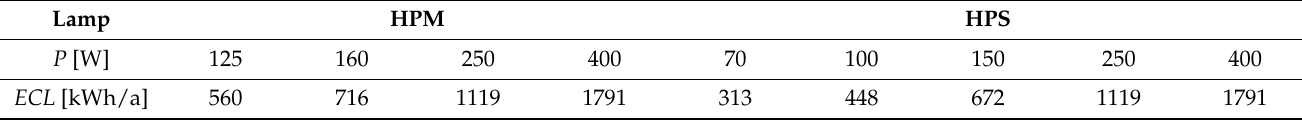
Table 5. Electricity consumption of existing HPM and HPS lamps in the city of Kragujevac.